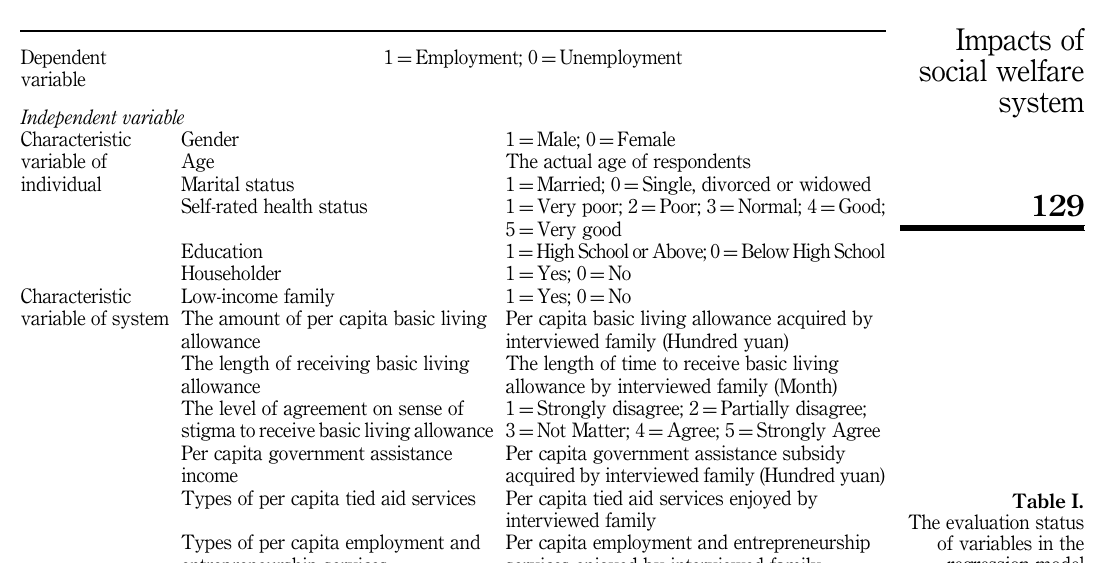
Table I. The evaluation status of variables in the regression model